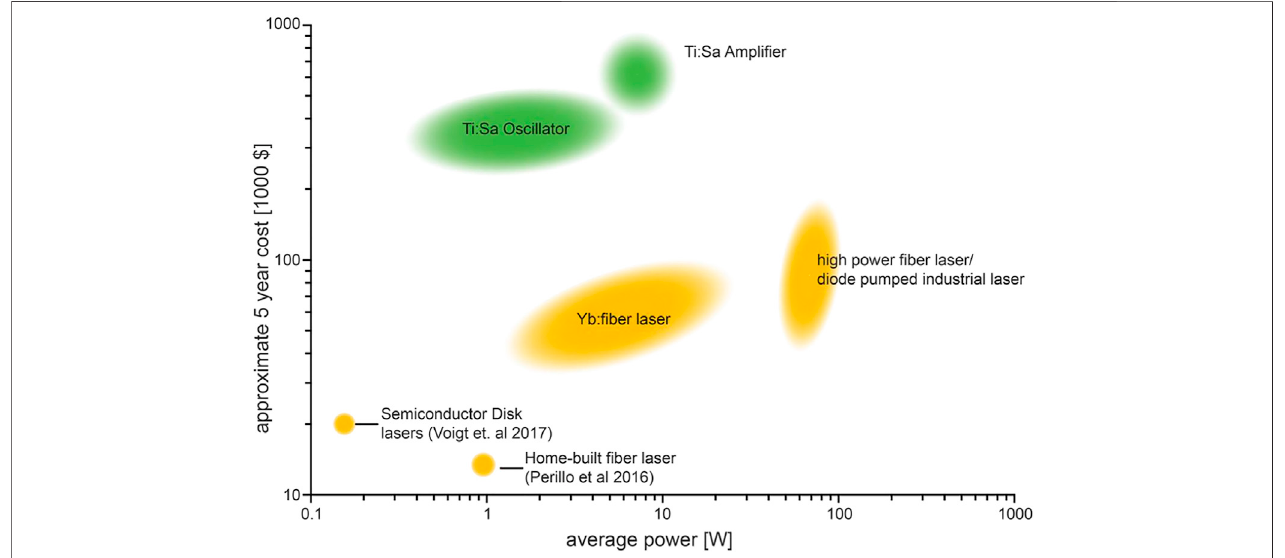
FIGURE7| Theapproximate5-yearscostsoftraditionaltunable2PAlasers(green)andalternative fi xedwavelengthslasers(yellow),demonstratingtheeconomical bene fi ts of fi xed wavelength fi bre lasers. Reproduced from the supplementary material of ref (Mohr et al., 2020) with permission from the authors.